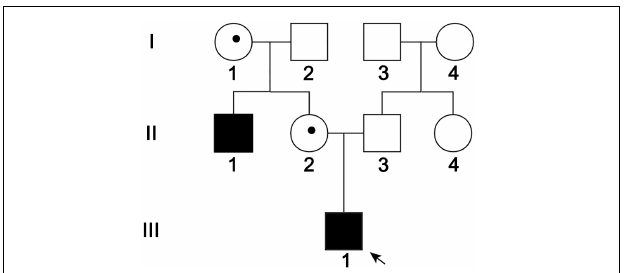
FIGURE 1 | Pedigree of the ND family. Black arrow: the propositus. II-1 and III-1 were patients, I-1 and II-2 were female carriers, and the others were normal